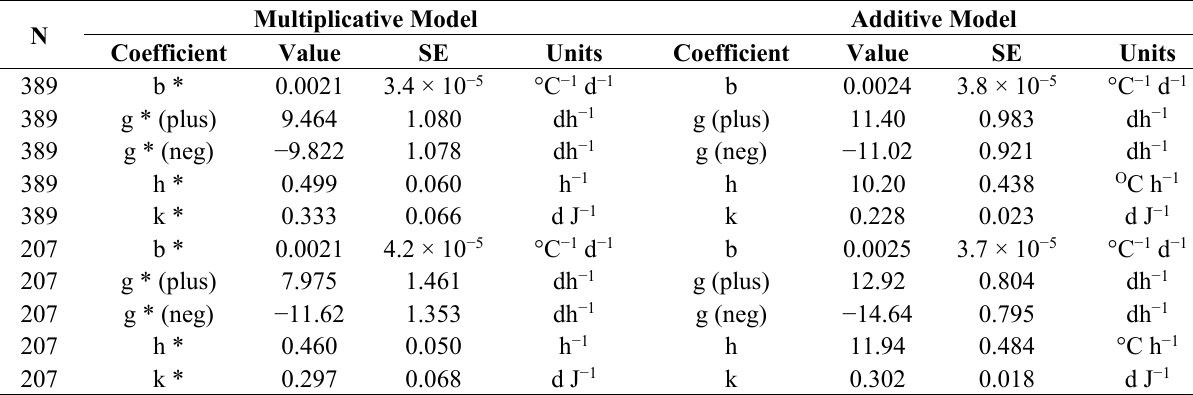
Table 3. Non-photoperiod coefficients for modeling soybean flowering time (with standard errors (SE) and units) obtained by least squares fitting to observations of times from planting to first flower from a full (N = 389) and reduced (N = 207) dataset. Coefficients are found in Equations (7), (11), (13) and (14) (additive model) and Equations (9), (12) and (15) (multiplicative model). Multiplicative model coefficients are denoted with an * while additive model coefficients do not have an